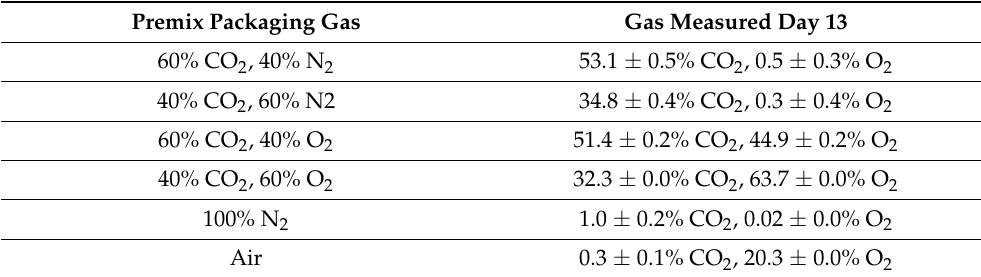
Table A2. The different packaging gas mixtures used for packaging of cod agar plates for growth screening, and the measured levels (%) of CO 2 and O 2 after 13 days of refrigerated 4 ◦ C storage of at total storage period of three